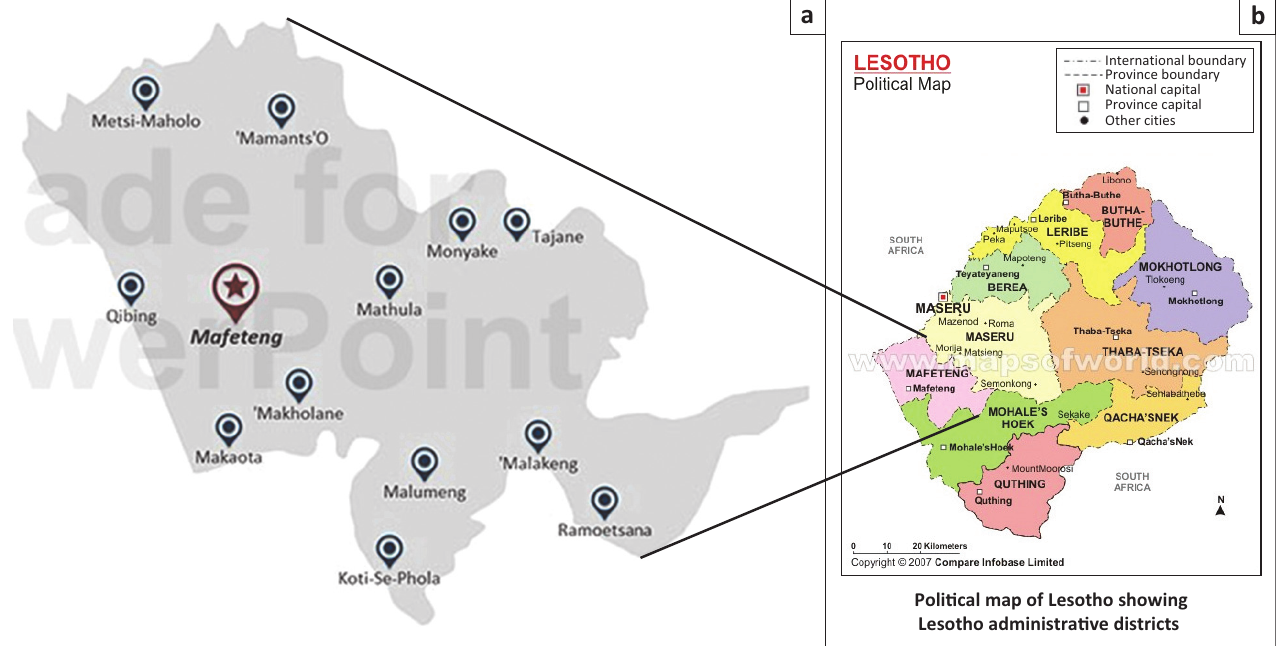
Poli(cid:27)cal map of Lesotho showing Lesotho administra(cid:27)ve districts